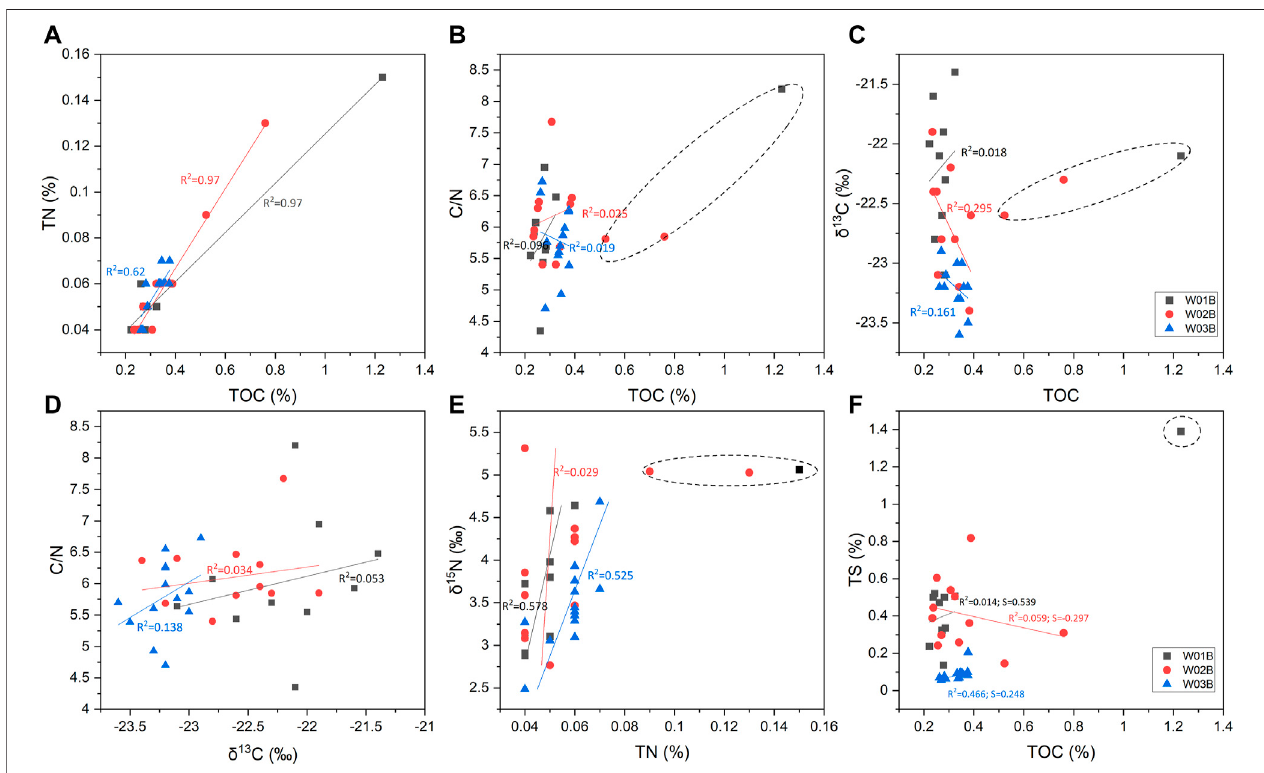
FIGURE 4 | Scatterplots of (A) TN versus TOC, (B) C/N ratio versus TOC, (C) δ 13 C org versus TOC, (D) C/N ratio versus δ 13 C org , (E) δ 15 N versus TN, and (F) TS versus TOC of the sediment of W01B, W02B, and W03B from the Shenhu area, SCS.